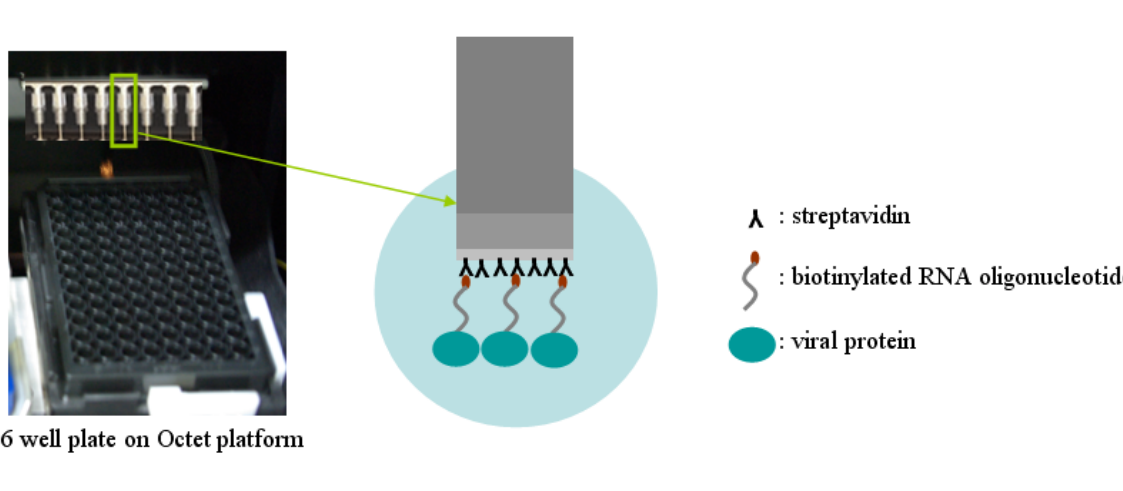
Figure 1. A representative scheme for detection of viral protein using streptavidin-biotin conjugation method on the Octet